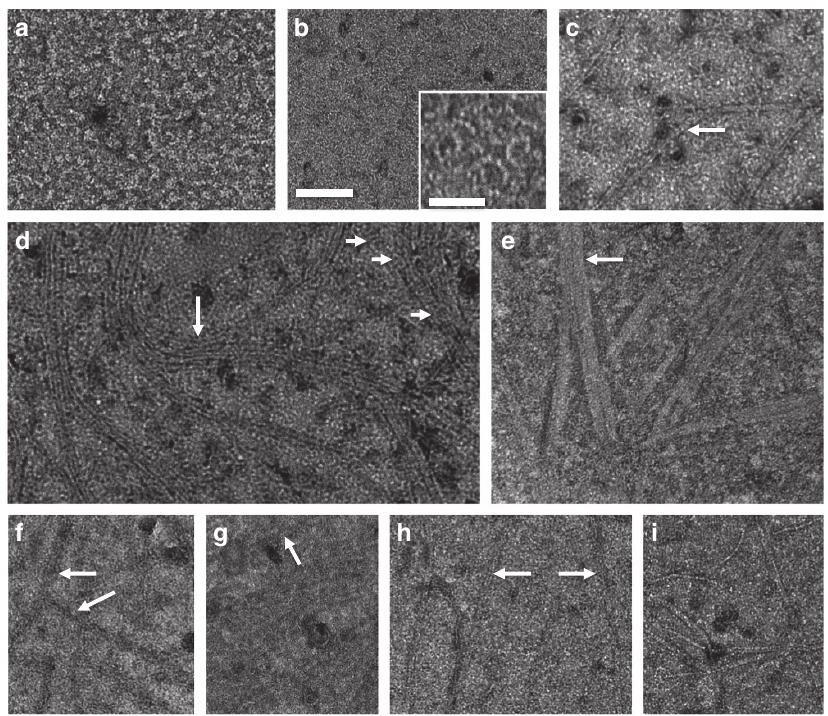
Figure 6 | Assembly of FtsA* and FtsZ* on lipid monolayers and their effects on FtsZ and FtsA higher-order assembly. ( a ) The 0.1 m M FtsA*, showing short straight polymeric structures; ( b ) 0.5 m M FtsA*, showing mostly arcs and short curved protofilaments. Inset shows (cid:3) 2.5 magnification of a portion of the image, highlighting some FtsA* arcs (scale bar in inset, 40nm). ( c ) The 0.1 m M or ( d ) 0.5 m M FtsA* þ 5 m M FtsZ, showing bundling of FtsZ protofilaments (large arrow) and FtsA* arcs (smaller arrows). ( e ) The 0.5 m M FtsA* þ 5 m M FtsZ*, showing assembly of very large FtsZ protofilament bundles/sheets (arrow). ( f , g ) The 0.5 m M FtsA þ 5 m M FtsZ*, showing persistence of FtsZ* bundles in the presence of FtsA minirings. ( h ) Same as ( f , g ) except with 2.5 m M FtsZ*. Arrows highlight FtsZ* protofilament bundles. ( i ) Mock experiment with FtsZ* on monolayers, but no FtsA added, showing an unusually dense area with FtsZ* polymers on the monolayer for comparison. Scale bar,